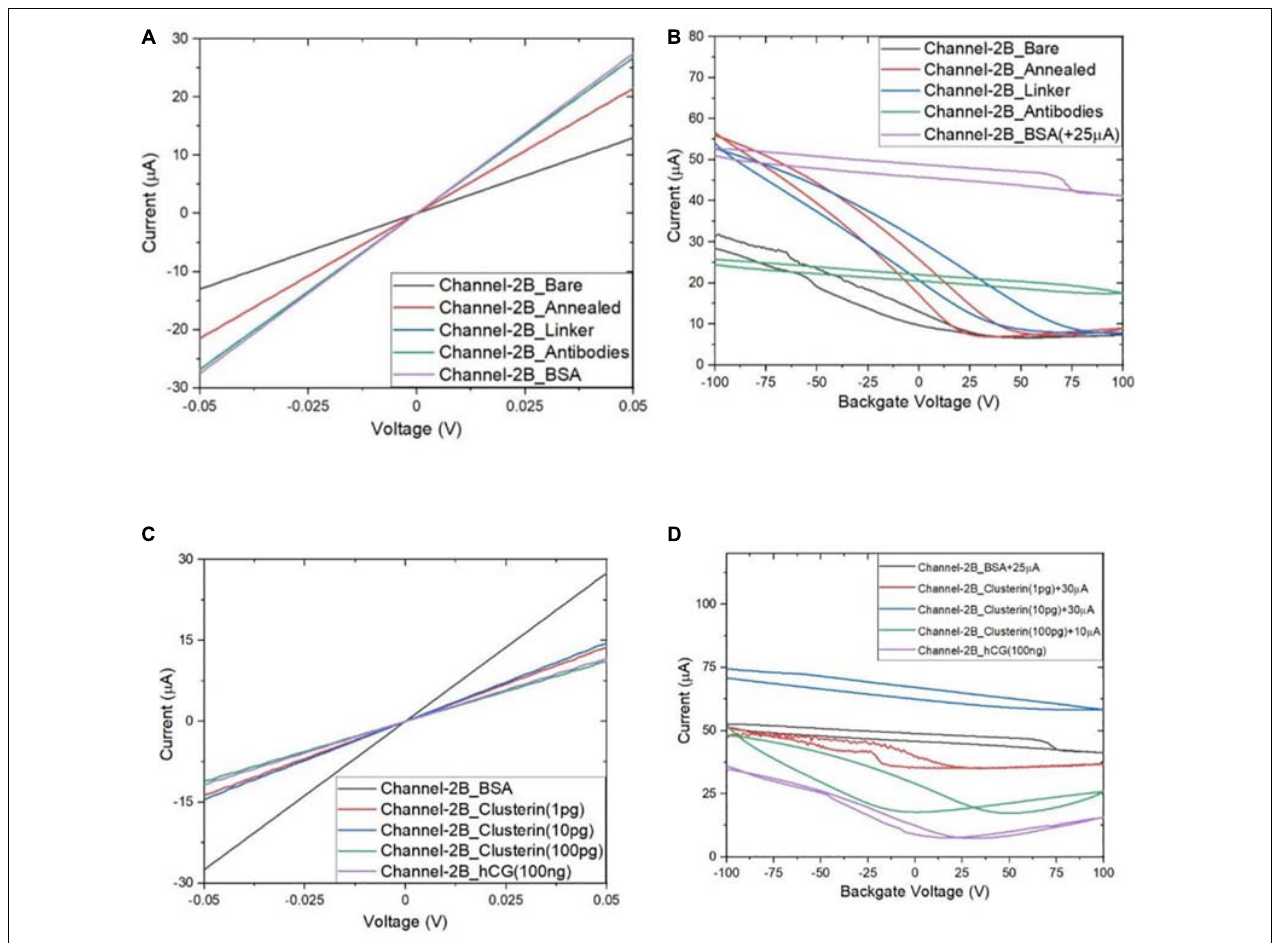
FIGURE 10 | Characteristic curves for Channel-2B (A) I D –V D output curve for bare to BSA, (B) I D –V G transfer curve for bare to BSA, (C) I D –V D curve for BSA to hCG (100 ng/mL), and (D) I D –V G curve for BSA to hCG (100 ng/mL), with off-set currents shown for clarity. Antigen concentrations are in units of g/mL. TABLE 2 | Measured resistance and resistance change (%) for bare to BSA stages of functionalisation for the three channels and the corresponding mean and standard deviation values.